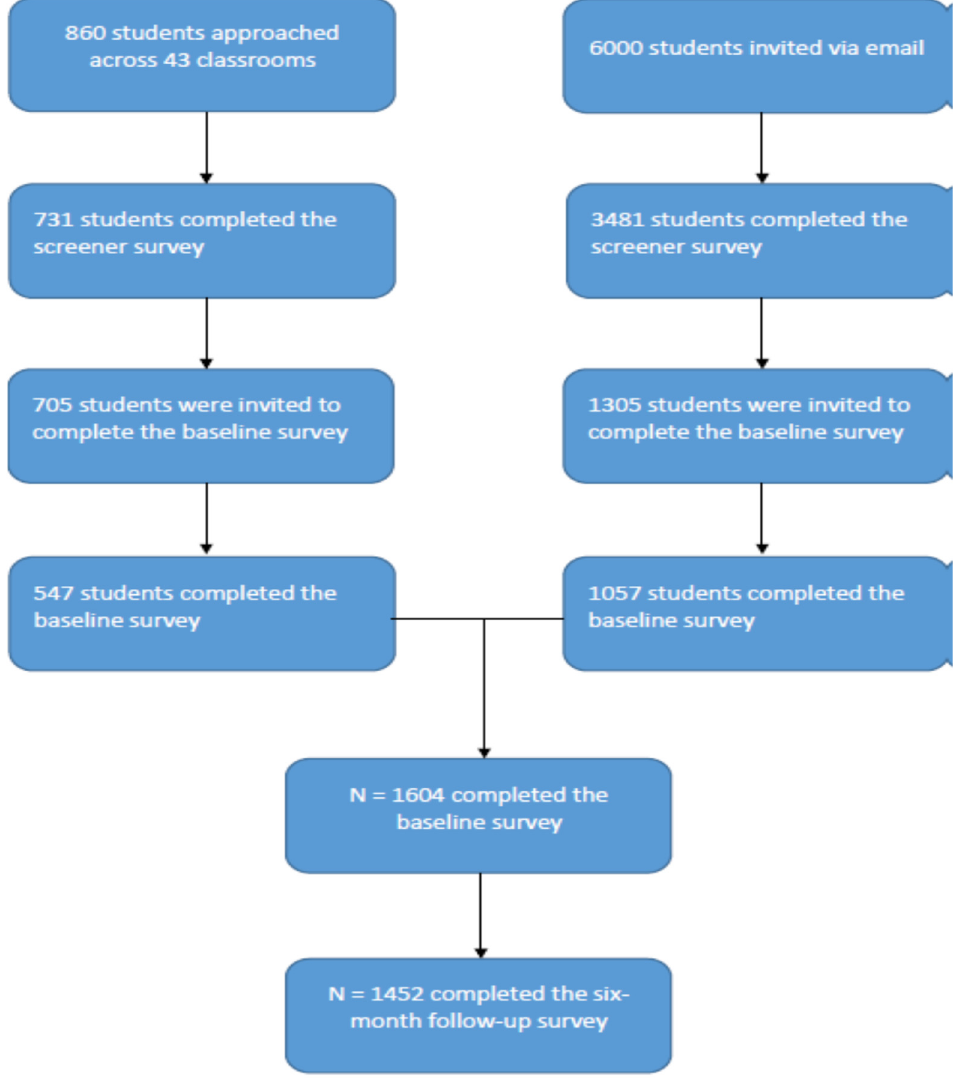
Figure 1. Flow-chart representing the recruitment procedures. Note that the analyses in the present study excluded “Other” ethnicity, because of which the analysis sample sizes are different than those presented in the figure.